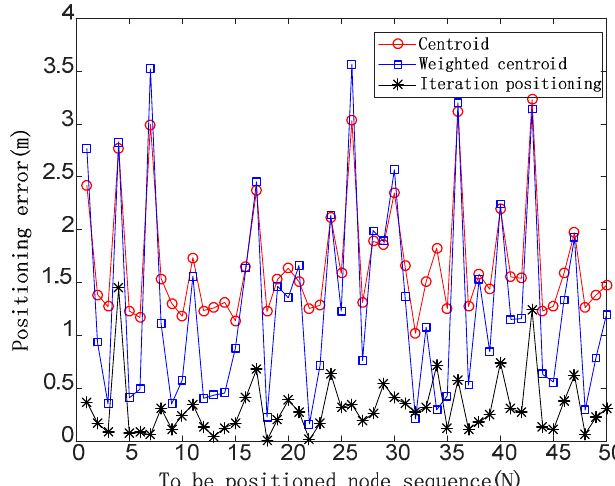
Figure 7. Positioning errors of three positioning algorithms in the case of the noise impact factor of 0.2. When F N is 0.2, the average positioning errors of the three algorithms are 1.68, 1.30, and 0.42, respectively, and the positioning accuracy of the iterative positioning algorithm is improved by 75% and 67.69% compared with the centroid algorithm and the weighted centroid algorithm. F N = 0.3